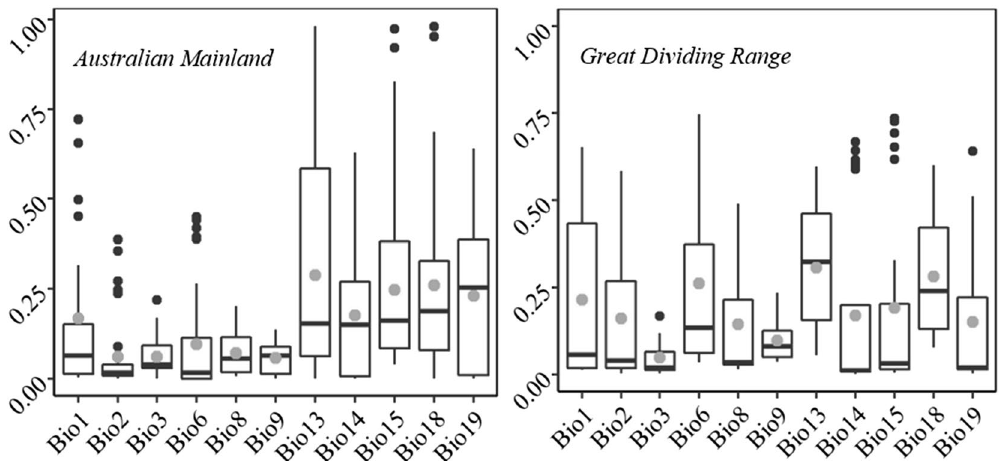
Figure 2. Variable importance for bioclimatic variable only individual algorithms. For description, see Fig. 1. The figures were generated in R (version 3.6.0, https ://www.r-proje